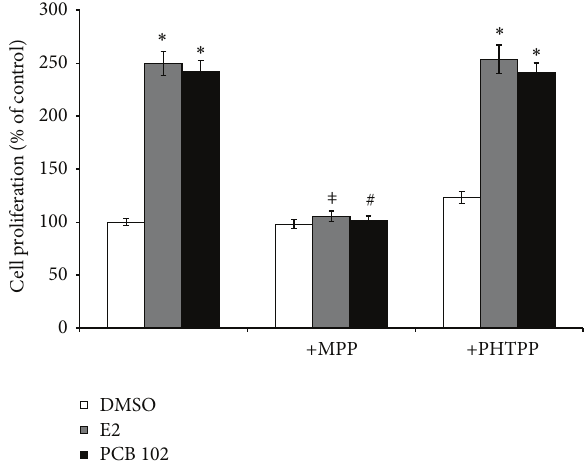
Figure 2: PCB 102-induced cell proliferation is mediated by ER 𝛼 . MCF-7/BOS cells were treated with 1 nM E2 or 5 𝜇 M PCB 102 with and without the ER 𝛼 -specific inhibitor MPP (1 𝜇 M) or the ER 𝛽 - specific inhibitor PHTPP (1 𝜇 M) for 72 hours. Cell numbers were determined by hemocytometer and expressed as a percentage of the DMSO control (set at 100%). Values are expressed as mean ± SE ( 𝑛 = 3 ). ∗ Significantly different compared to control, 𝑃 < 0.05 ; (cid:2) significantly different compared to E2 treatment, 𝑃 < 0.05 ; and # significantly different compared to PCB treatment, 𝑃 < 0.05 .